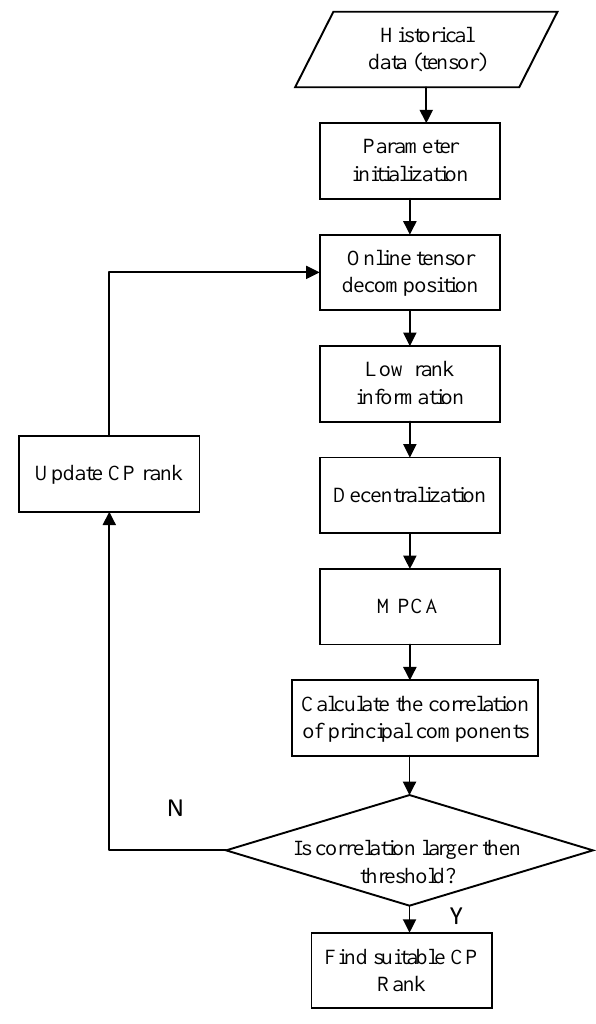
Figure 9. Flow chart of CP Rank estimation (Algorithm 2).